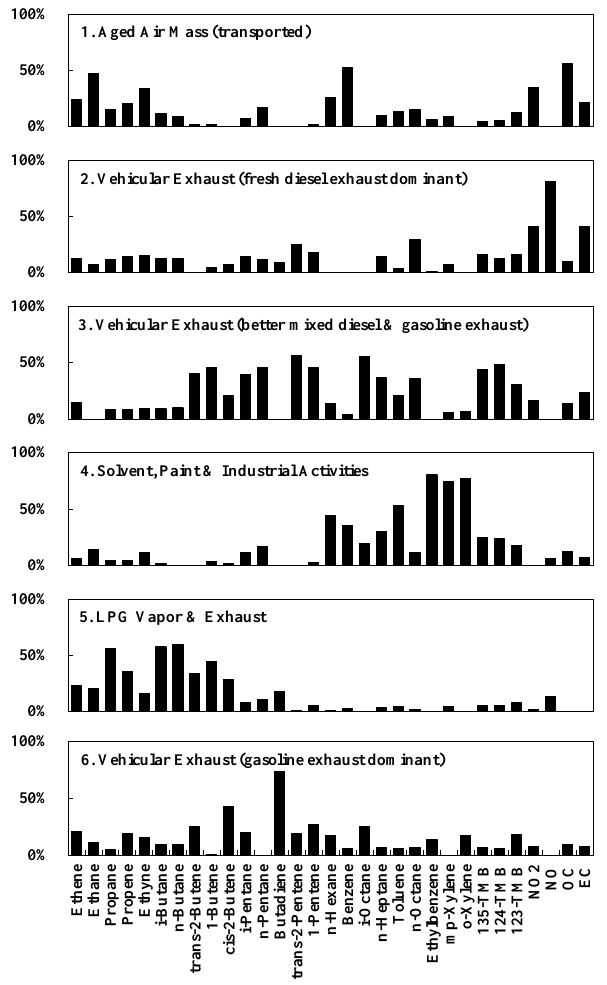
Figure 7 . Source profile (% of species total) identified by USEPA PMF3.0. Figure 7. Source profile (% of species total) identified by USEPA